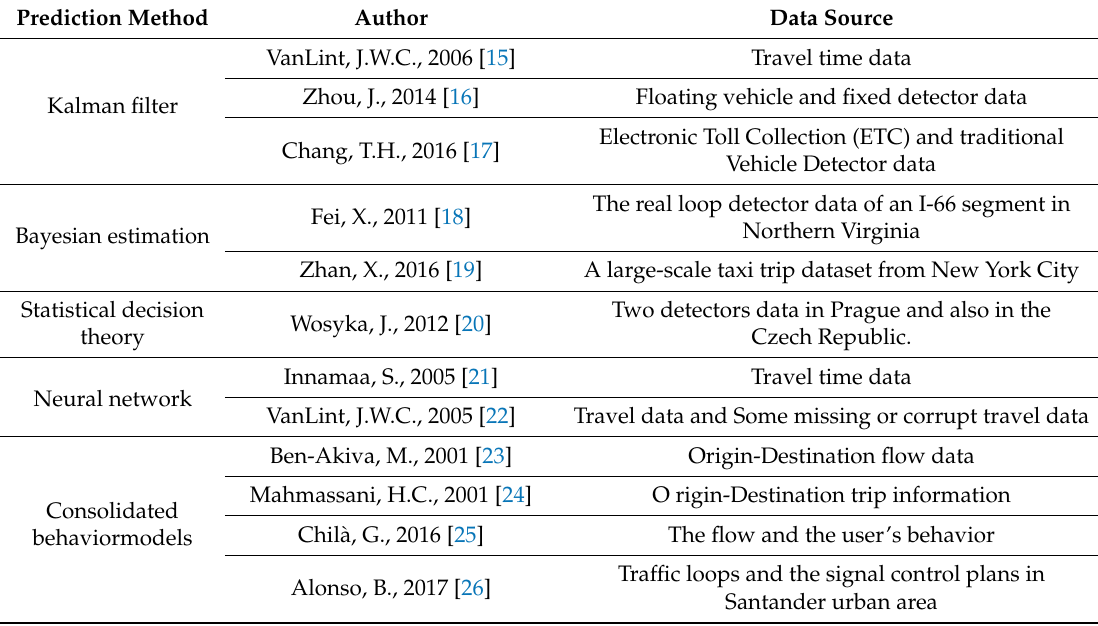
Table 1. Comparison of common prediction